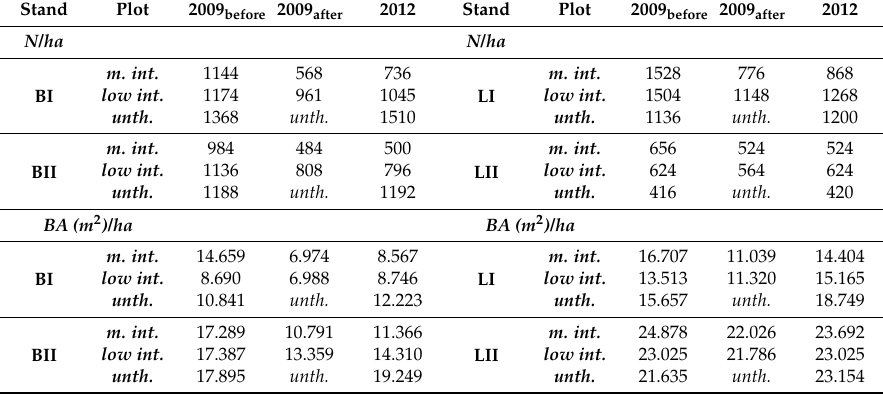
Figure 2. Non-spatial harvest event analysis of the Altansumber birch and larch thinning trials; grey: trees remaining after thinning; black: trees removed during the thinning. Table 3. Stand measures of the plots before (2009 before ), after the thinning (2009 after ) and at the end of the observation period in 2012. N/ha = stem number per hectare; BA/ha=basal area per hectare; dom. height (m) = dominant height; CV: diameter coefficient of variation; m. int. = medium intensity treatment; low int. = low intensity treatment; unth. = no treatment (unthinned).